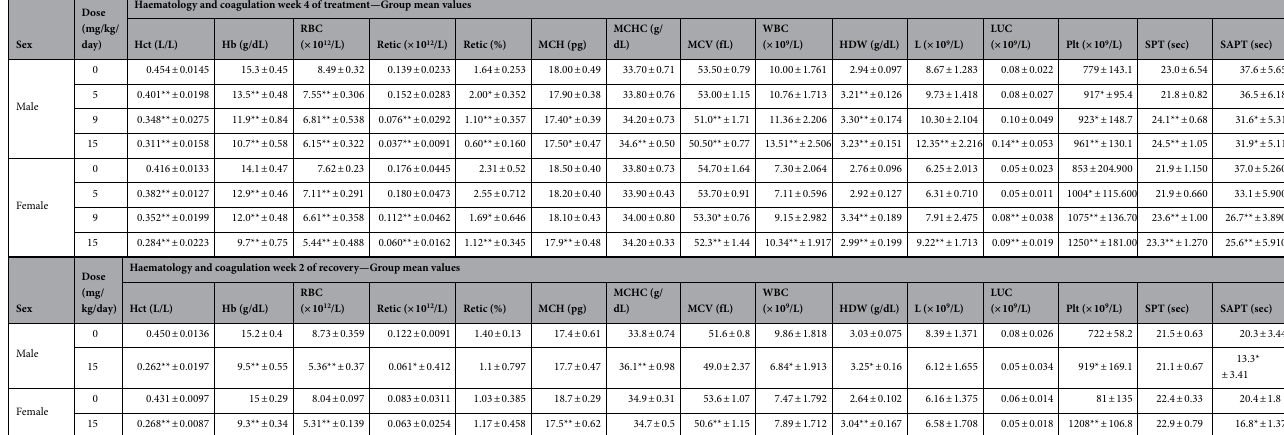
Table 2. Major changes obtained in haematology and coagulation measurements (group mean values ± standard deviation) in male and female rats treated intravenously for 4 weeks and 2 weeks of recovery period with 0 (vehicle = 0.9% saline solution), 5, 9 and 15 mg/kg/day of SET-M33 peptide. Hct haematocrit, Hb haemoglobin, RBC erythrocyte count, Retic reticulocyte count (absolute and relative), MCH mean corpuscular haemoglobin, MCHC mean corpuscular haemoglobin concentration, MCV mean corpuscular volume, WBC leukocyte count, total, HDW haemoglobin concentration distribution width, L lymphocytes, LUC large unstained cells, Plt platelet (thrombocyte) count, SPT prothrombin time, SAPT activated partial thromboplastin time. Significant differences between peptide vs. control groups were expressed at the 5% (* p < 0.05) or 1% (** p < 0.01) level. For statistical analysis, Dunnett, Shirley’ Williams, Wilcoxon and t tests were